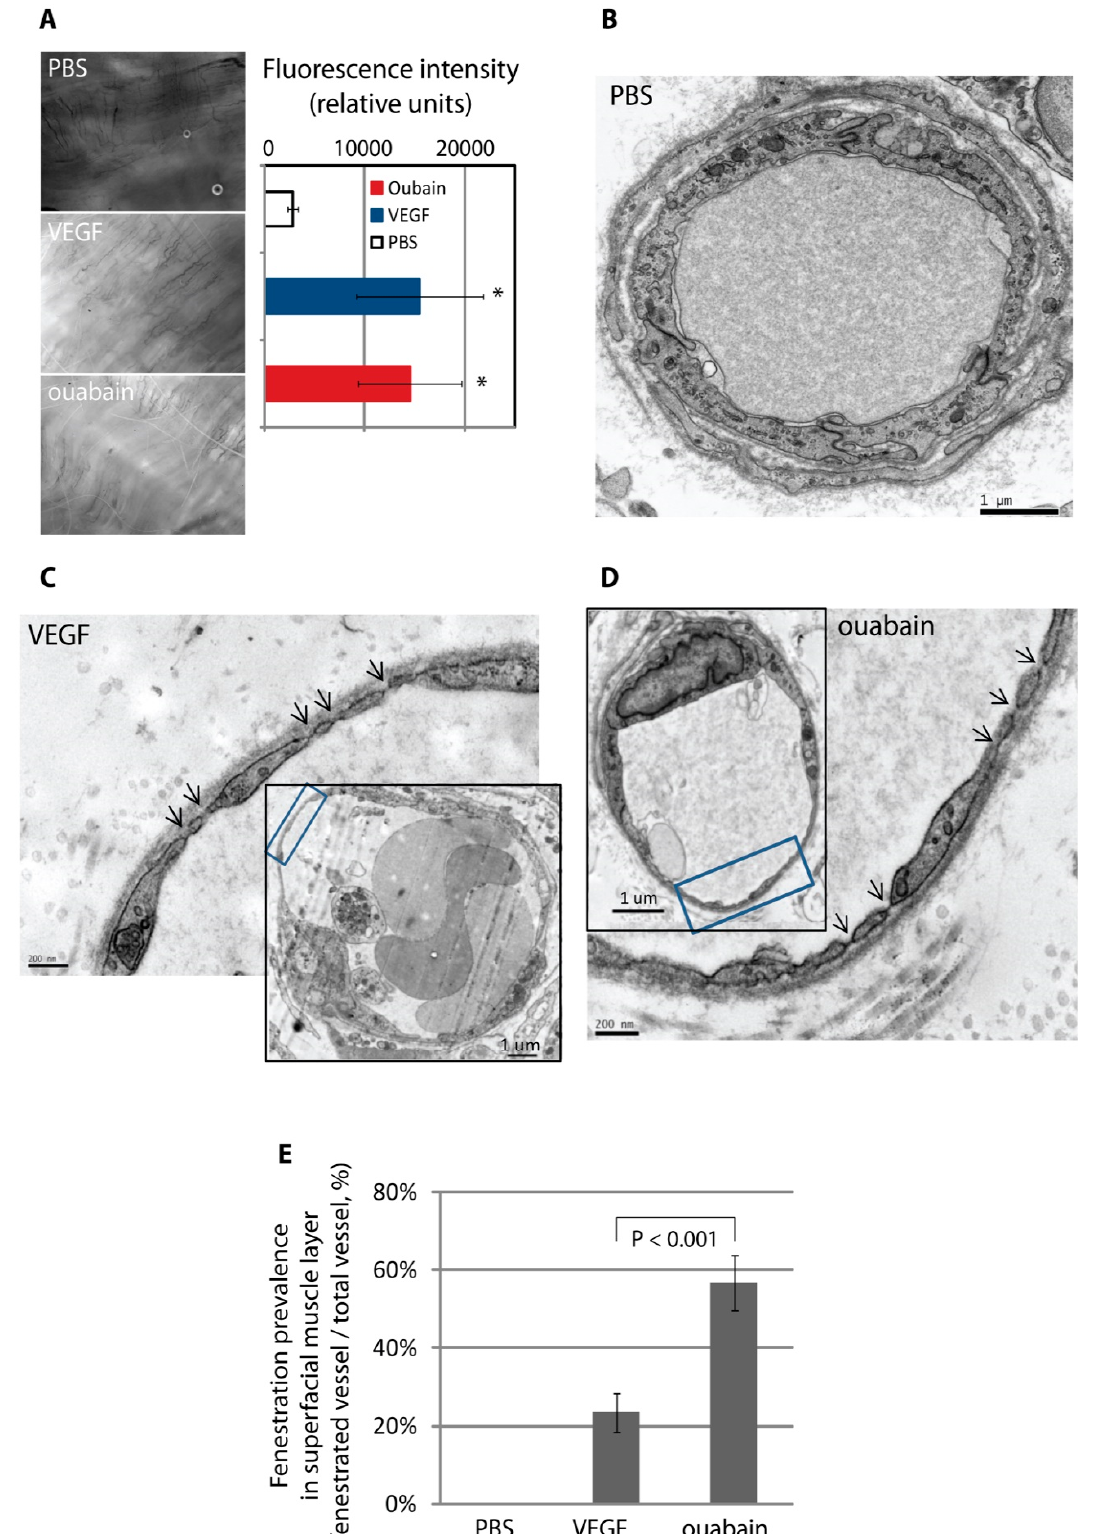
Figure 8. Inhibition of the Na,K-ATPase pump induces fenestra formation in vivo. ( A ) Ouabain increased vascular permeability in rat cremaster muscle. PBS (100 µ L), VEGF-164 (75 ng in 100 µ L), and ouabain (200 µ M, 100 µ L) were topically applied on surgically exposed rat cremaster muscle. Leakage of a fluorescent systemic tracer (fixable 3kD fluorescent dextran) was significantly increased 10 min after exposure to VEGF-164- or ouabain-treated samples. Error bars represent ± SEM; n = 3; * P < 0.01. ( B – D ) ouabain induced fenestra formation in vivo. Rat cremaster tissue subjected to topical